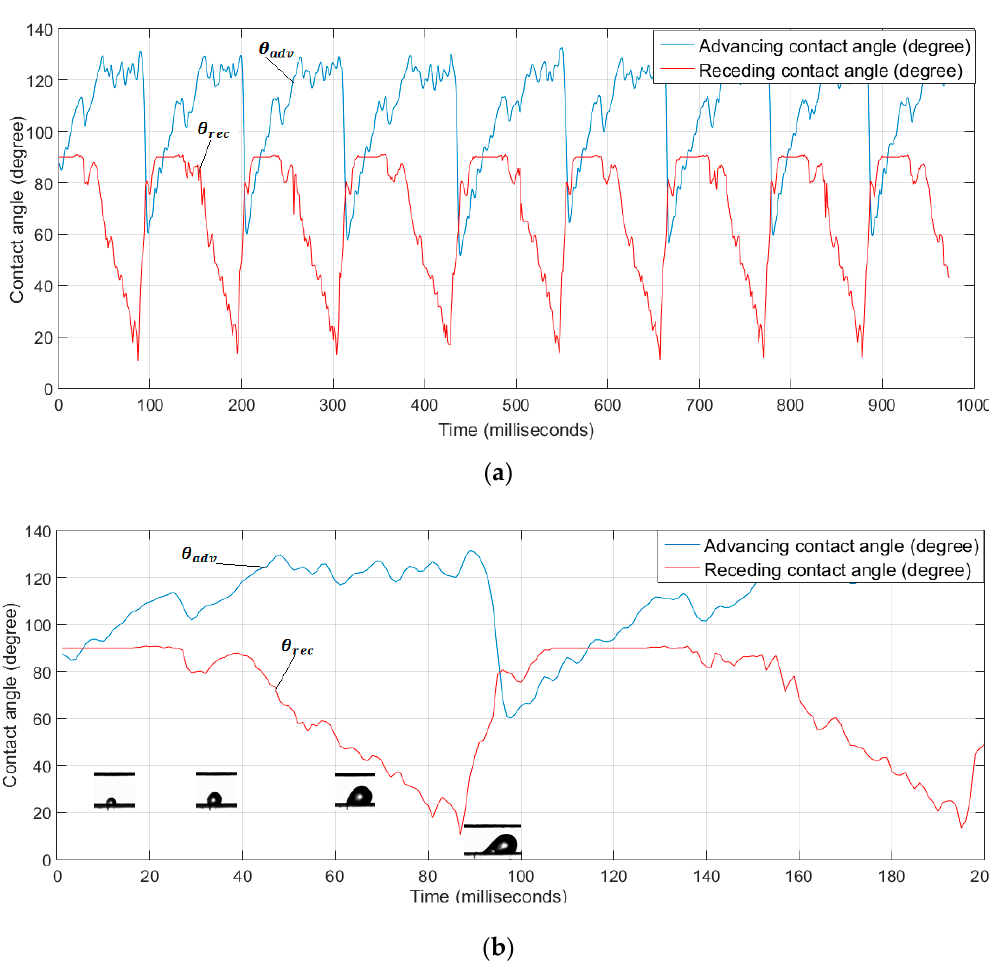
Figure 14. Dynamic contact angles. ( a ) Contact angles resulting from image processing; ( b ) Droplet cycle: Advancing and receding contact angles (obtained for Q w = 1 µ L / min, Q air = 37.5 SCCM).